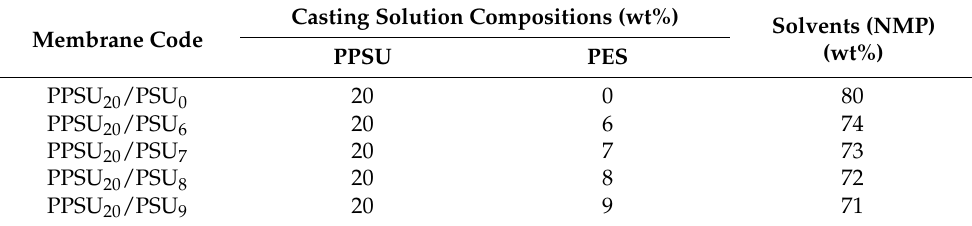
Table 1. Compositions of PPSU/PSU blend solutions and PWP of the membranes.